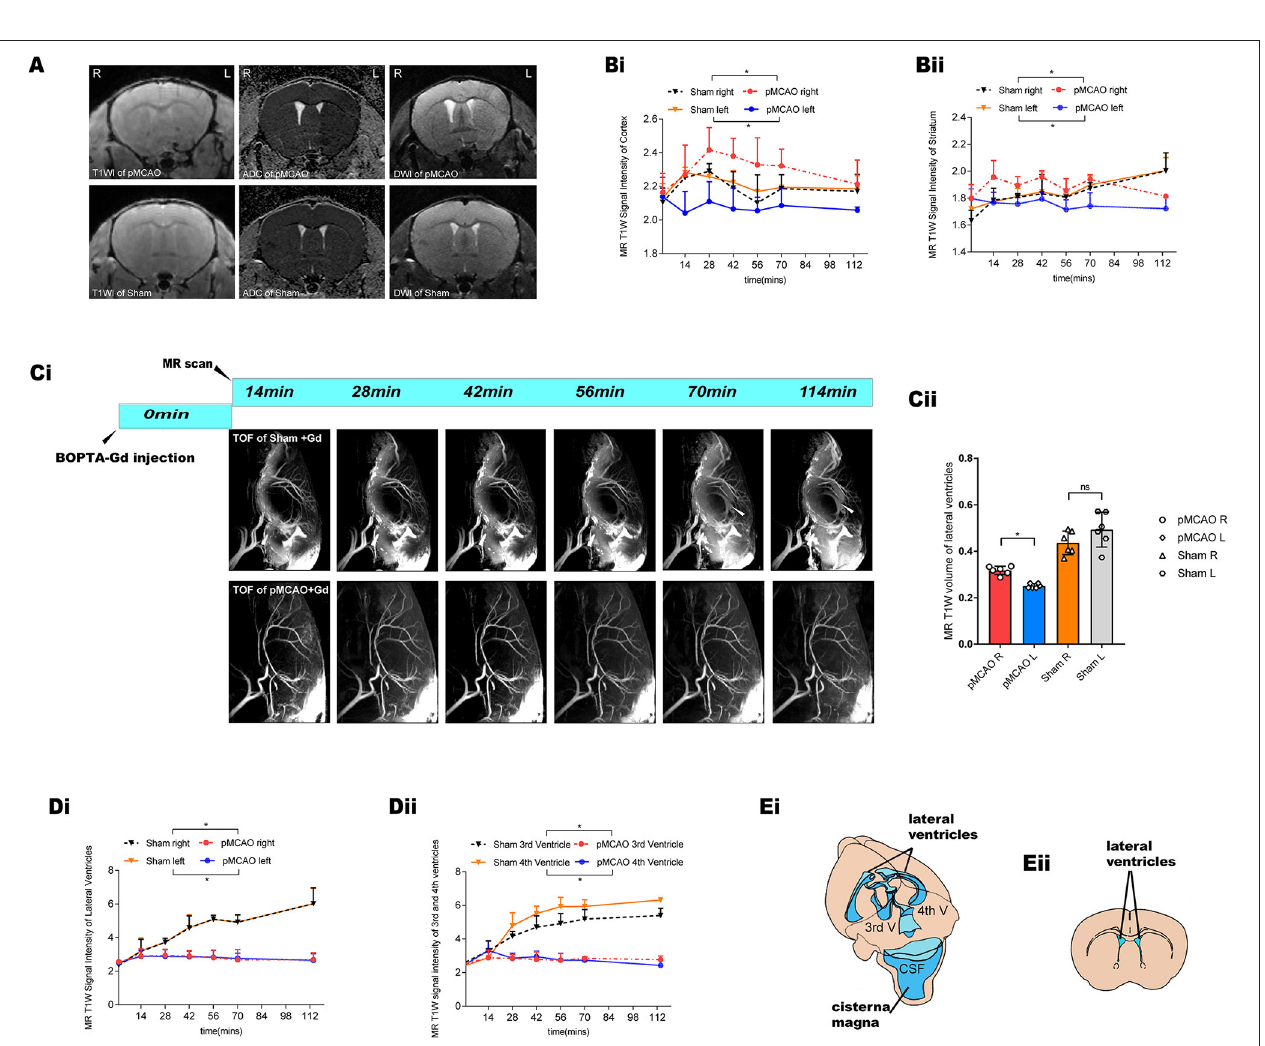
FIGURE 3 | Glymphatic transport kinetics were impaired after the onset of ischemic edema in the pMCAO mice. (A) Representative T1W images, DWI, and ADC maps of pMCAO and sham-operated animals with BOPTA-Gd injection. The serial acquisition of MR images was performed at an interval of about 12min and started at 28min after pMCAO and 14min after BOPTA-Gd injection. L indicates the pMCAO side. ROIs used for MRI quantification are as shown in Figure 2B . (B,D) The corresponding quantification of SI indicated the dynamic of tissue uptaking BOPTA-Gd tracers. Compared to the sham-operated animals, the T1W SI of the pMCAO group was decreased in the ipsilateral cortex/striatum (Bi,ii) and the bilateral cerebral ventricles (Di,ii) of the pMCAO brain ( n = 3 per group). Concurrently, the increase in the SI of the contralateral cortex/striatum was detected by the enhancement of contrast agent, as compared to the sham-operated group. (Ci) Representative TOF images demonstrate that glymphatic flow was impaired in the bilateral ventricles of mice after the onset of ischemic edema in pMCAO with BOPTA-Gd injection. (Cii) Corresponding quantification of ventricular volume changes in the pMCAO and sham-operated animals, for which a decrease in the volume of the ipsilateral ventricles was observed. (Ei) Schematic diagram of the anatomical position of ventricles, namely, bilateral (LV), third (3V), and fourth (4V) cerebral ventricles. Reproduced with permission (10) (Eii) Blue-dashed areas indicate the approximate ROIs used for MRI quantification of the lateral ventricle volume.